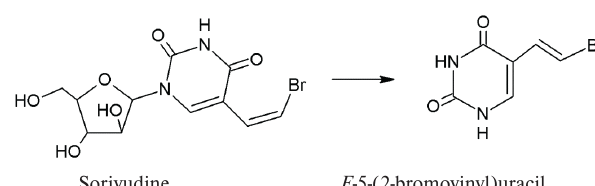
Fig. 5. Bacteroidetes sp. are responsible for lethal toxicity of sorivudine when concomitantly administered with 5-fluoro- uracil. sorivudine metabolite of bacterial metabolism, (e)- 5-(2-bromovinyl) uracil causes toxic level of anticancer drug 5-fluorouracil 85